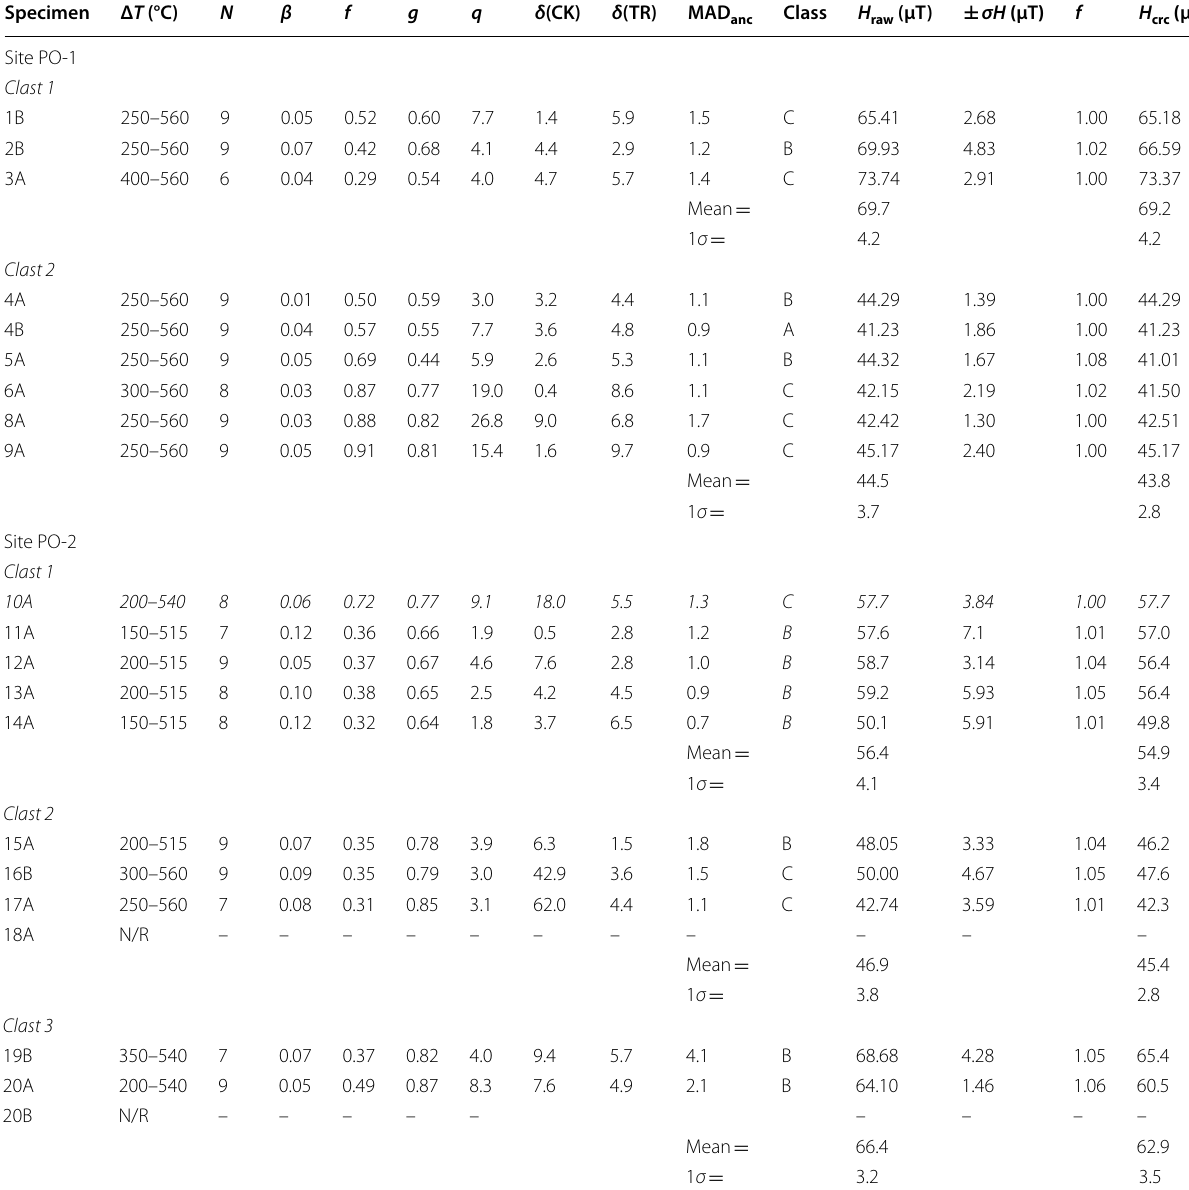
Table 3 Thellier–Coe paleointensity results for sites PO-1 and PO-2 (pyroclastic density currents)